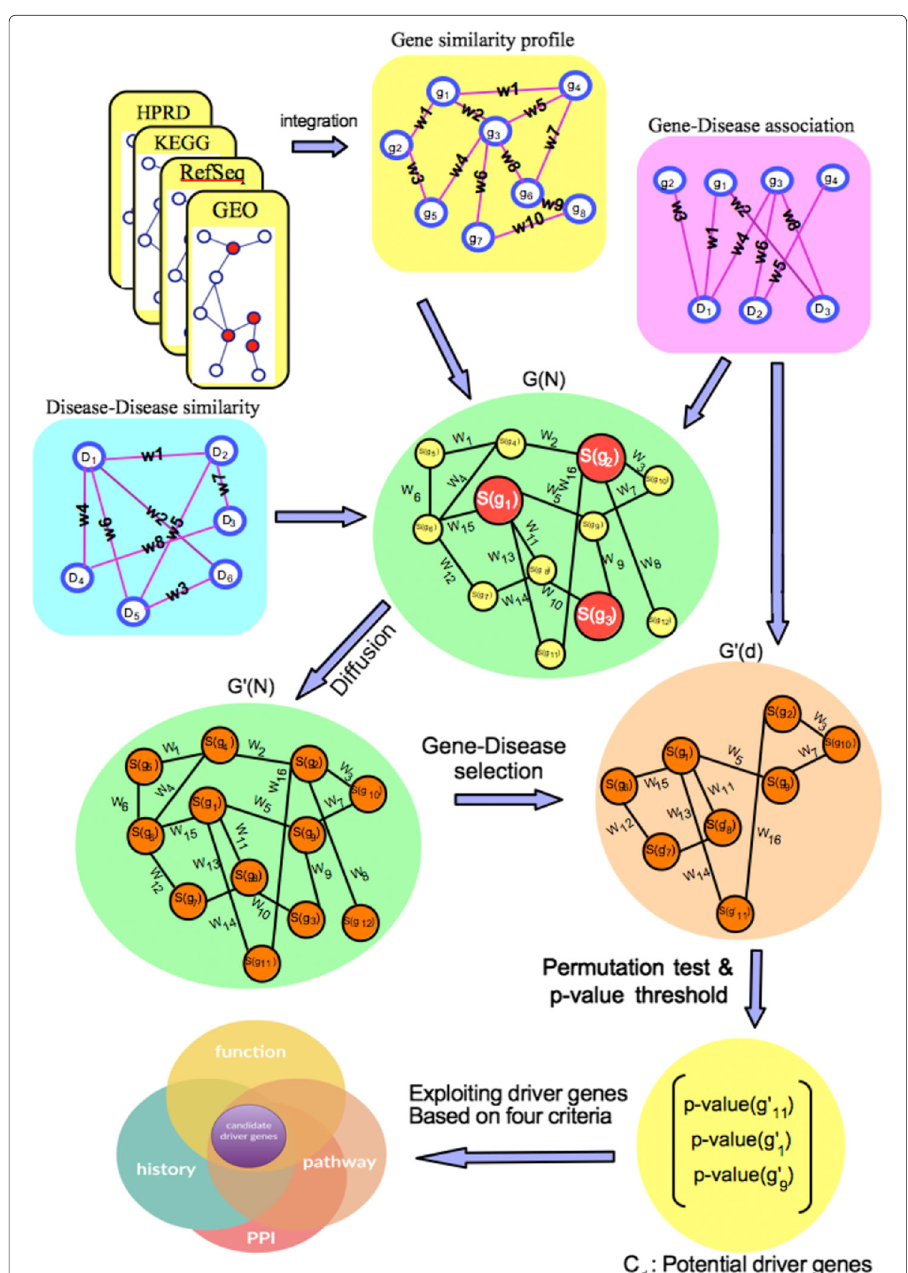
Fig. 1 Workflow of TOPDRIVER. The figure depicts genes by g i , edge weights by w i , disease by D i , and vertex score by S(g i ). Gene similarity matrix were constructed by integration of four datasets that were depicted in upper left corner. The G(N) were built with application of gene similarity matrix, disease-disease similarity matrix, and gene-disease association. The G(N) depicts the discrimination among gene scores by coloring high-scored vertices with red and the other low-scored vertices by yellow. As G’(N) shows, the jagged network was amended using diffusion kernel. Afterward, we select an induce graph using gene-disease association by finding a set of genes related to an intended disease. Finally, we applied a permutation test and p -value cut-off to choose related candidate